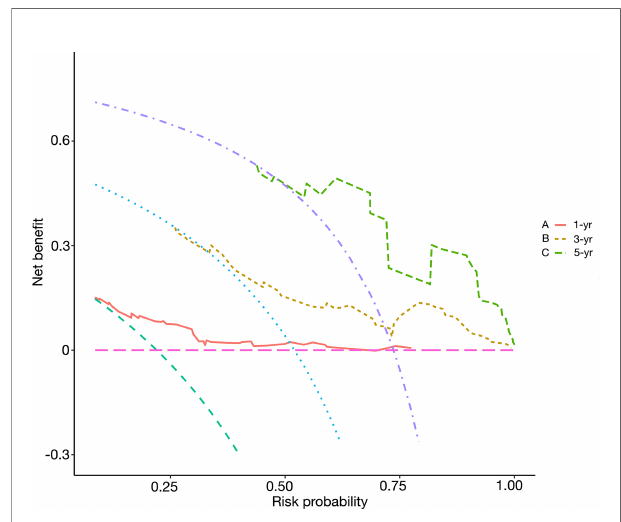
FIGURE 4 | Decision curves of the Peking University nomogram (PKUN) model. (A) for 1-year PFS, (B) for 3-year PFS, and (C) for 5-year